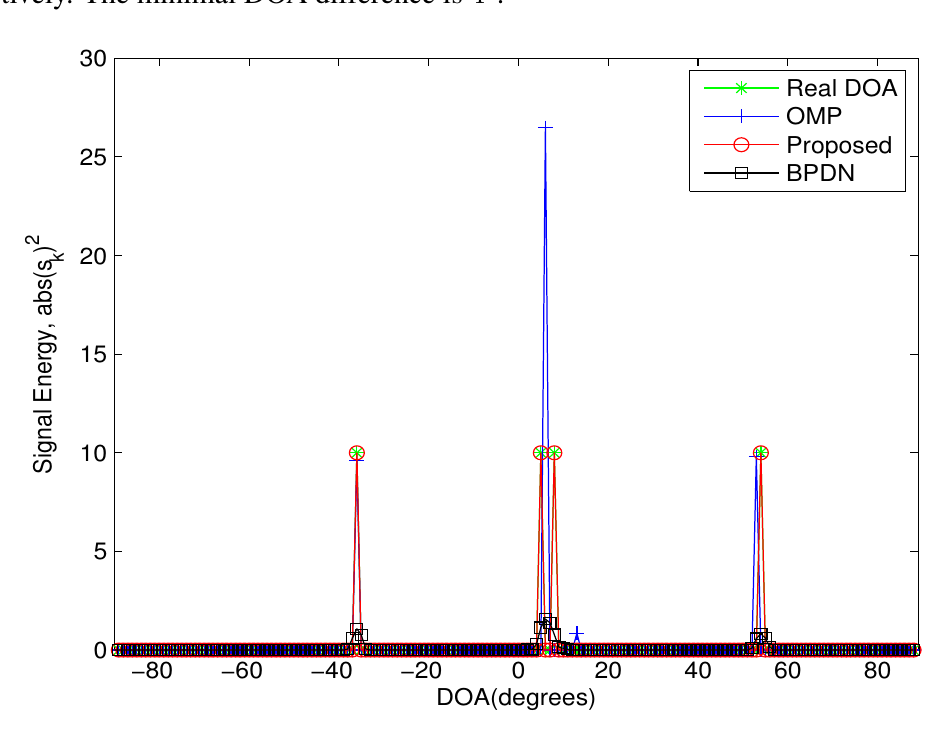
Figure 3. The performance comparison in the ideal case. Four sources are assumed from the DOAs: {− 36 ◦ , 4 ◦ , 8 ◦ , 54 ◦ } . The power of the sources and noise is 10 dB and zero, respectively. The minimal DOA difference is 4 ◦